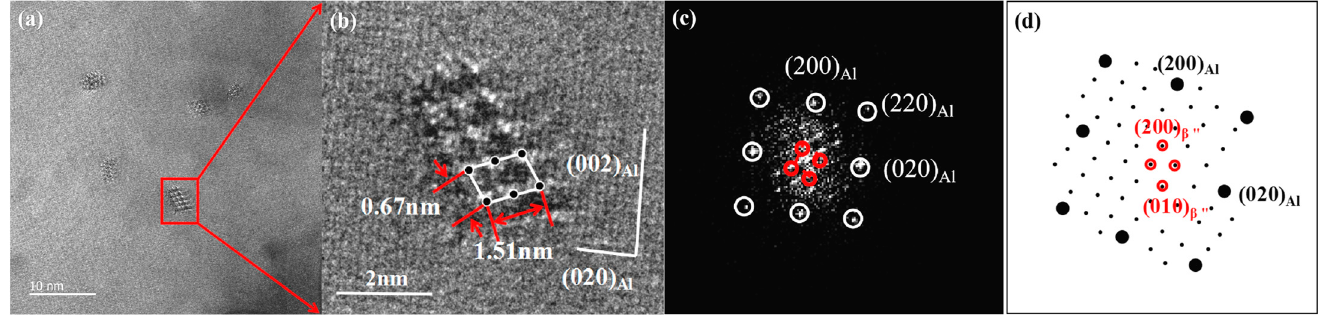
Figure 6. β″ phase in A1 alloy in the <010>Al axis after aging treatment: ( a ) TEM image, ( b ) HRTEM image, ( c ) corresponding FFT, ( d ) schematic pattern.